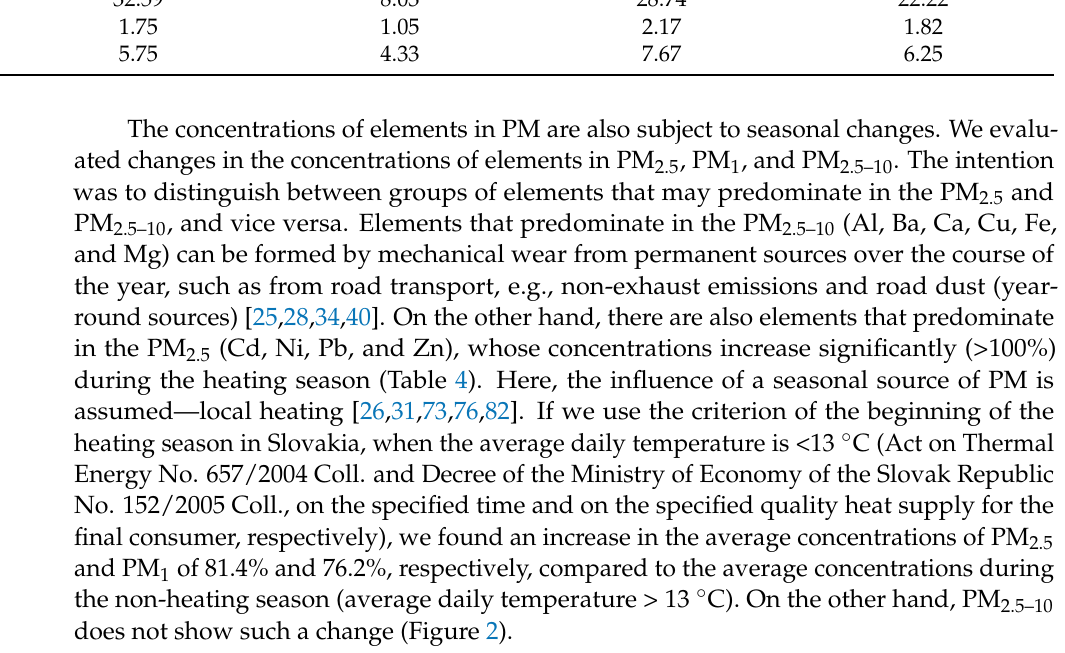
Table 4. Changes in the concentrations of elements in individual PM fractions during the heating season compared to the non-heating season. PM